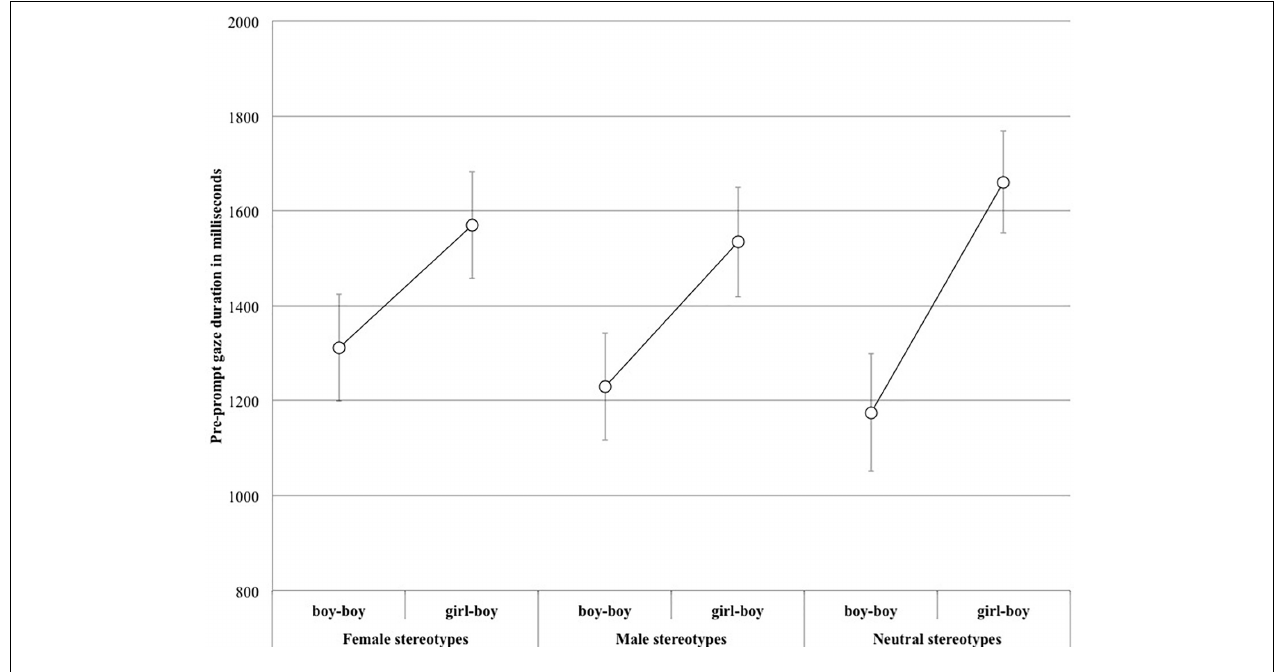
FIGURE 5 | Mean pre-prompt gaze duration (and standard errors) across Picture and Stereotype.